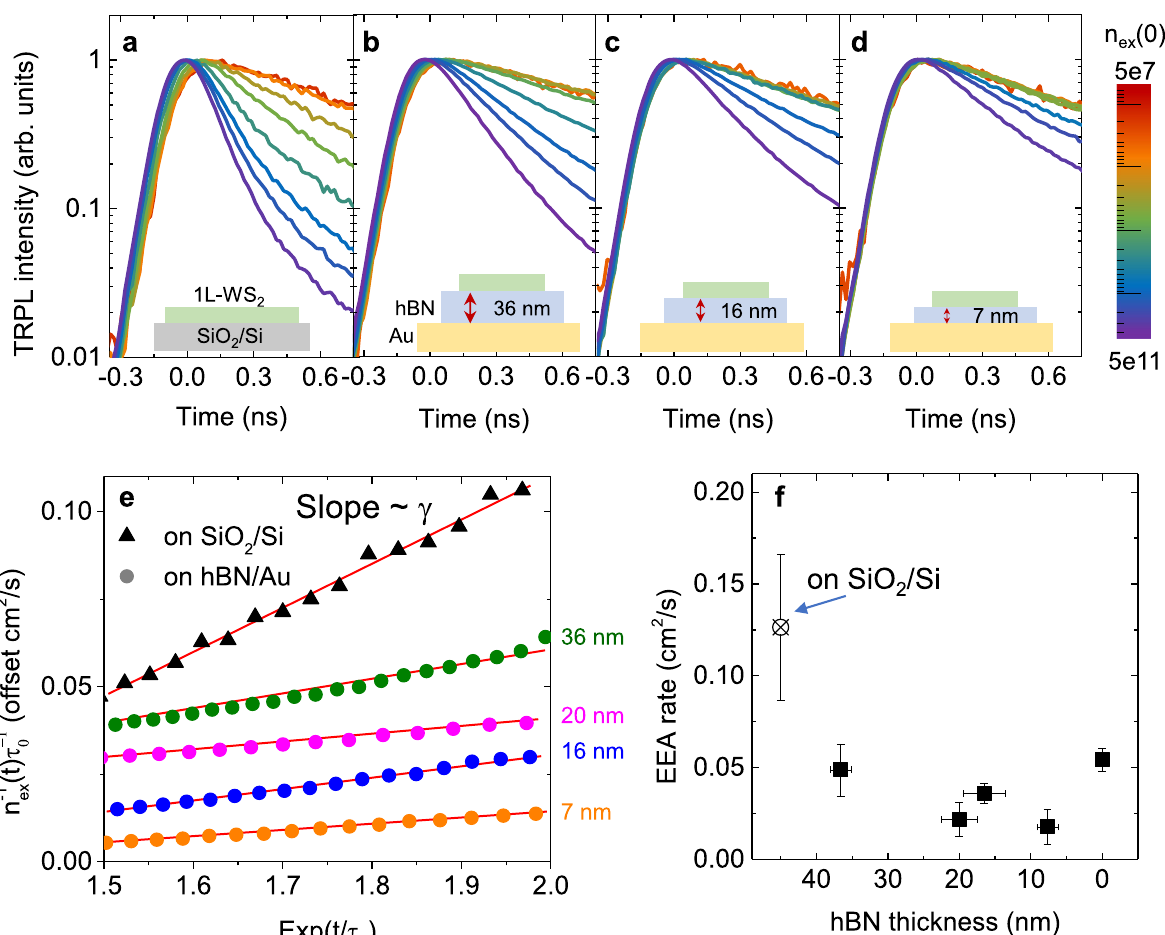
Fig. 3 Exciton dynamics vs. hBN thickness. a – d . Series of the normalized TRPL decay curves observed from 1L-WS 2 on several substrate geometries under various excitation levels (initial exciton densities). The corresponding substrate geometries are shown in the insets. The color codes in the right of d represent the initial exciton densities. e Plot of n (cid:2) 1 ex ð t Þ τ (cid:2) 1 vs. exp ð t = τ 0 Þ for 1L-WS 2 on SiO 2 /Si and hBN on Au for several thicknesses of hBN (shown on the 0 right axis). The data are vertically offset for comparison. The EEA rate is extracted from the slope of linear fi tting as shown by red solid lines. f Estimated EEA rate as a function of hBN thickness on Au (black squares) and directly on SiO 2 /Si (crossed circle). The error bars indicate the standard deviations of the hBN thickness measurement and the EEA rates estimated at different exciton